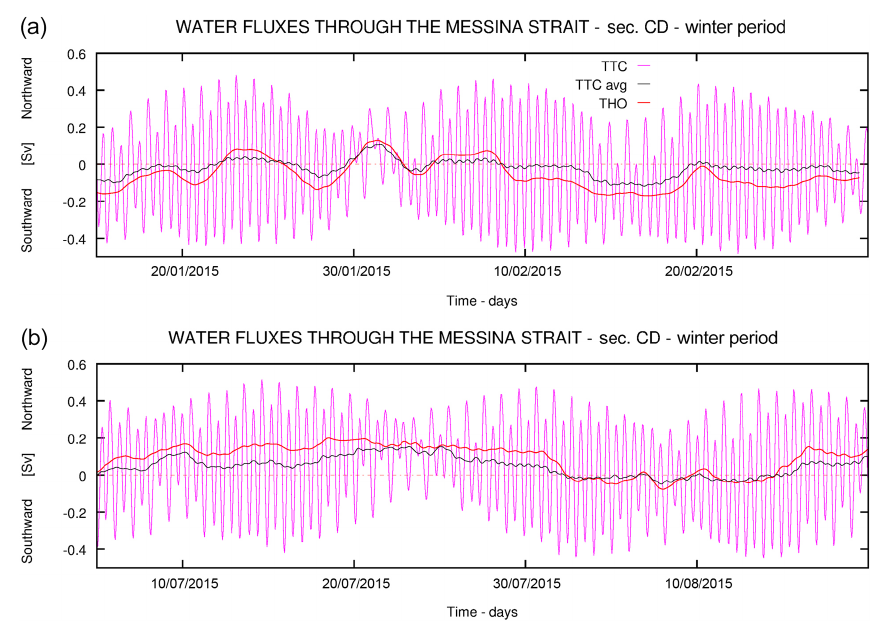
Figure 6. Water fluxes through sections C–D computed for 45 days during winter (a) and summer (b) periods from THO scenario results (red line) and from TTC scenario results (blue line for hourly data, black line for daily data); units are expressed in Sv, with negative values indicating southward flux (ebb flow) and positive a northward flux (flood